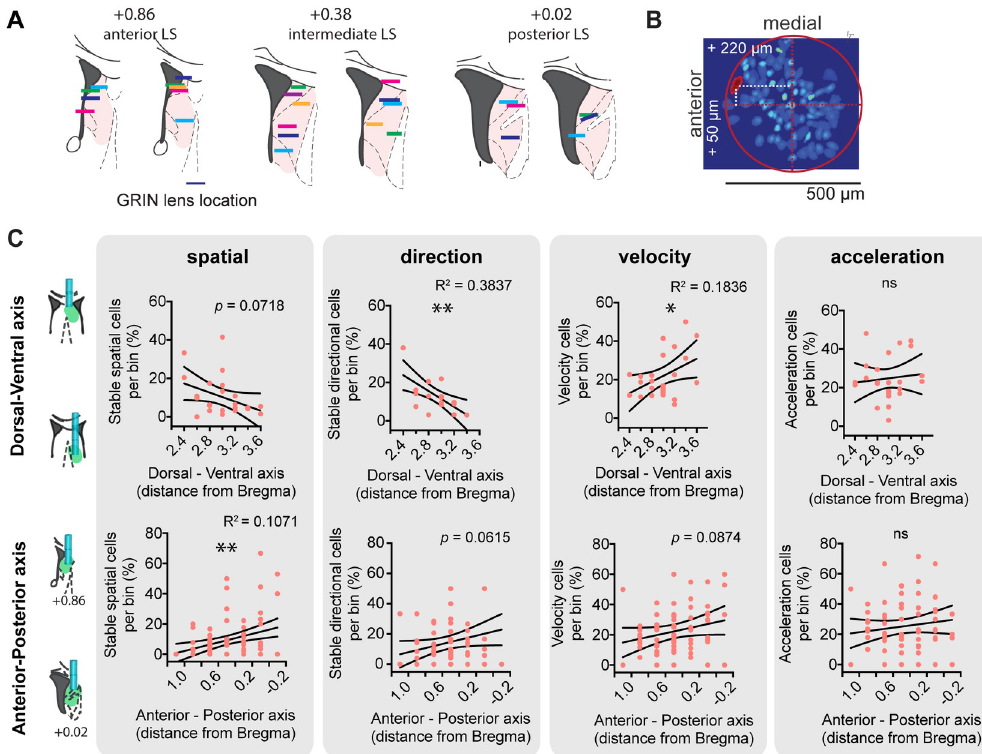
Fig 7. LS cells coding for space, direction, and self-motion correlates are nonuniformly distributed along the dorsal– ventral and anterior–posterior axis. (A) Strategy to record from different anterior–posterior levels in LS (left) and implantation sites covered. (B) Strategy to approximate cell location. Background: maximal projection of representative recording; red: outline of approximated GRIN lens position; white: distance from the center of the GRIN lens to the cells of interest. (C) Top: for 0.2 mm bins along dorsal–ventral axis, proportion of stable (within-session stability > 0.5) spatially modulated cells ( n = 24 mice), directionally modulated cells ( n = 17 mice), velocity cells ( n = 24 mice), and acceleration cells ( n = 24 mice), respectively. Bottom: same as top for anterior–posterior axis. Each red dot represents the average per animal per bin along the anterior–posterior axis (left) and along the dorsal–ventral axis. Black lines indicate 95% confidence intervals. � , p < 0.05, �� , p < 0.01. Test used in C: linear regression. The underlying data can be found in S1 Data. GRIN, gradient refractive index; LS, lateral septum; ns, not